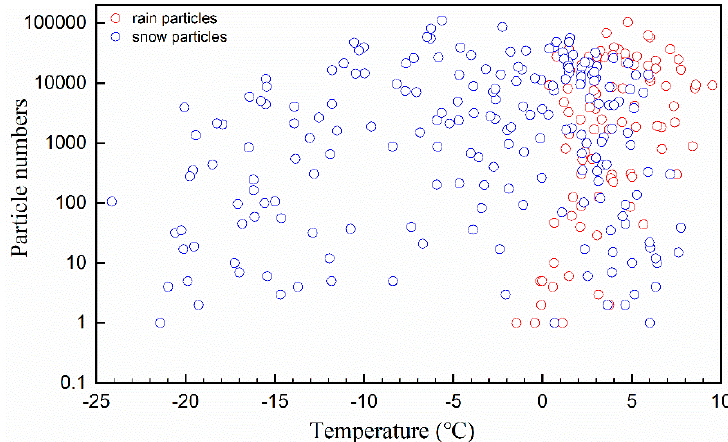
Figure 5. Distribution of rain and snow particles with temperature. (with a logarithmic scale on the Y-axis).